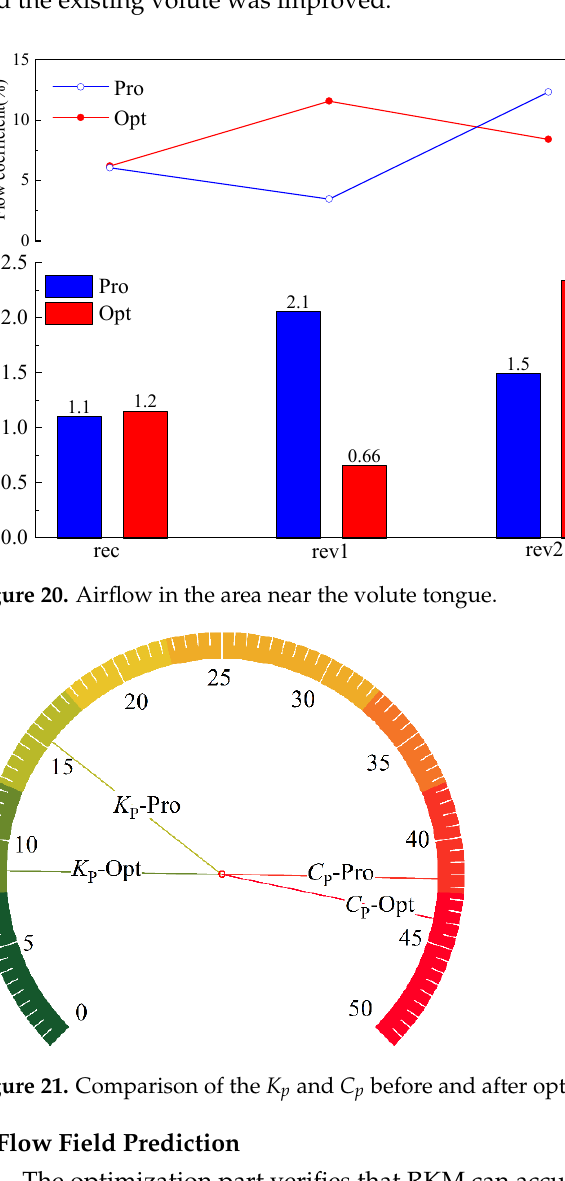
Q rev1 Figure 19. Airflow in the area near the volute tongue.